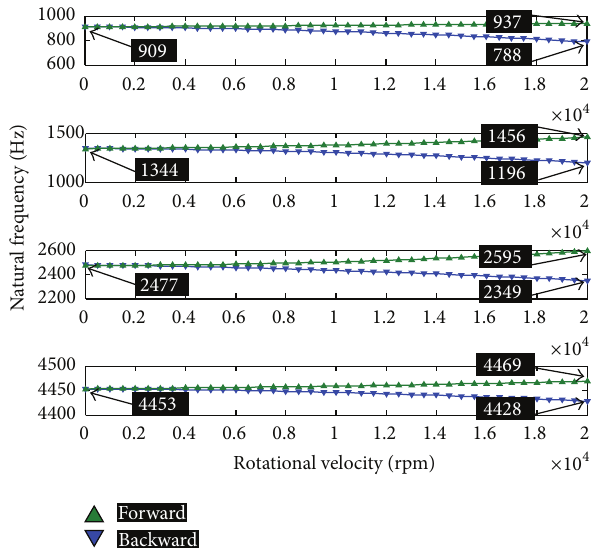
Figure 14: Centrifugal force and gyroscopic moment effects of shaft simultaneously.